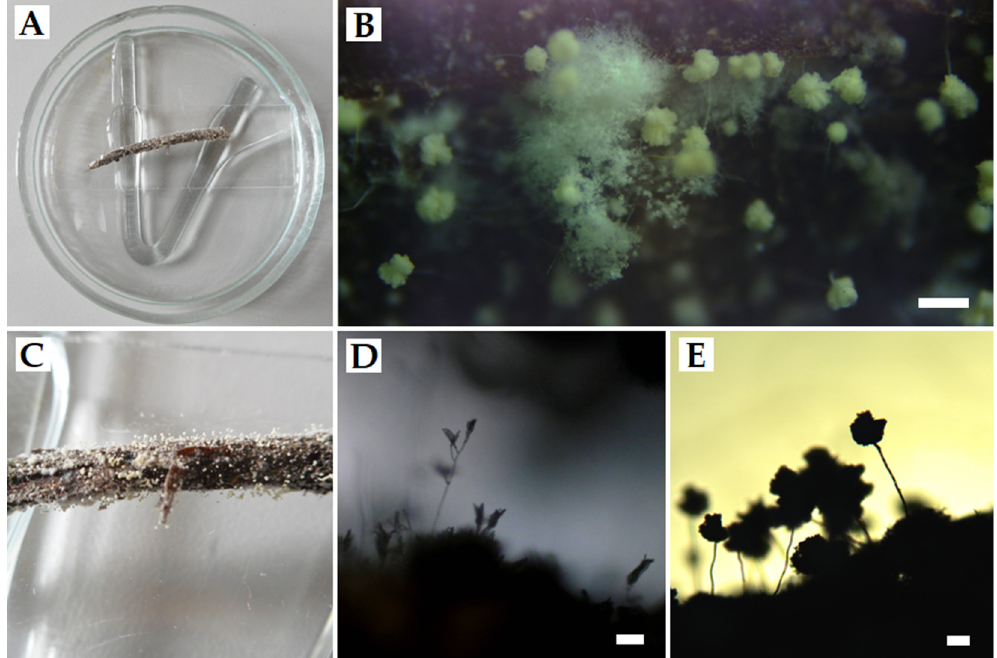
Figure 3. Nest fragments ( A , C ) after 28 days at 23 ± 0.5 °C incubation in a damp chamber and visible